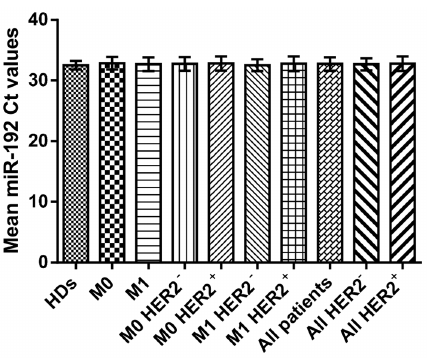
Figure 1. Mean threshold cycle values of miR-192 ± standard deviation in the serum of breast cancer patients and healthy donors. No significant differences in mean threshold cycle (Ct) values of miR-192 were observed among the serum of different groups (Kruskal–Wallis test, p=0.785).